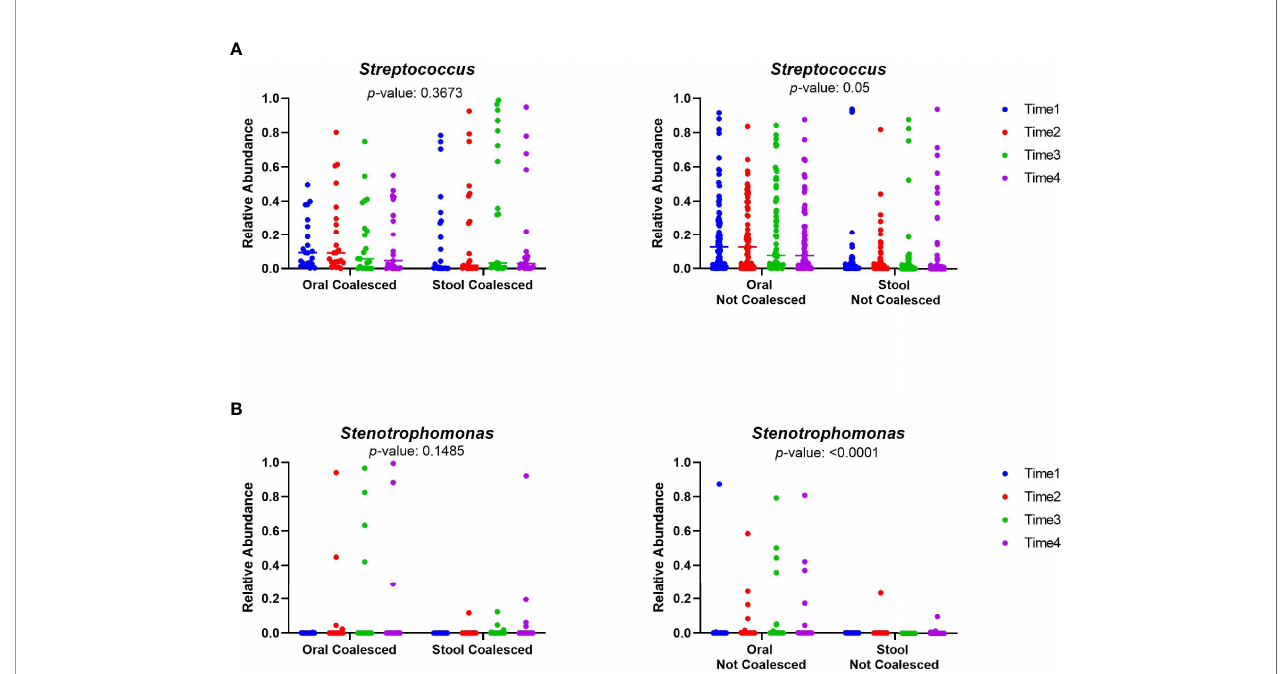
FIGURE 5 | The relative abundances of Streptococcus and Stenotrophomonas are not signi fi cantly different between the oral and stool of coalesced patients. The relative abundance of selected oral bacteria (A) Streptococcus and (B) Stenotrophomonas was plotted for oral and stool samples. The relative abundance within each sampling time points for both oral and stool is plotted individually. The color scale indicates sampling time point for each of the patient samples, where blue is the fi rst timepoint sampled, and purple is the last sampling time point. P-values were calculated between oral and stool samples utilizing a mixed model for repeated